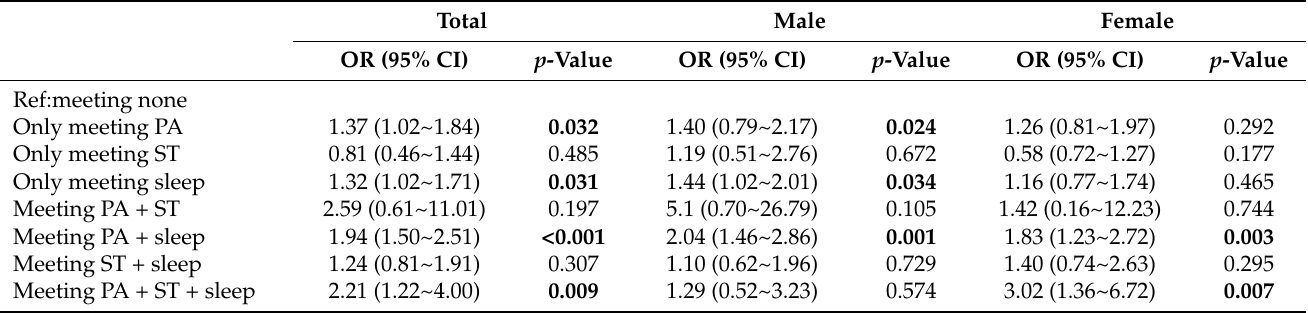
Table 5. The relationship between meeting 24-HMG categories and physical health in the